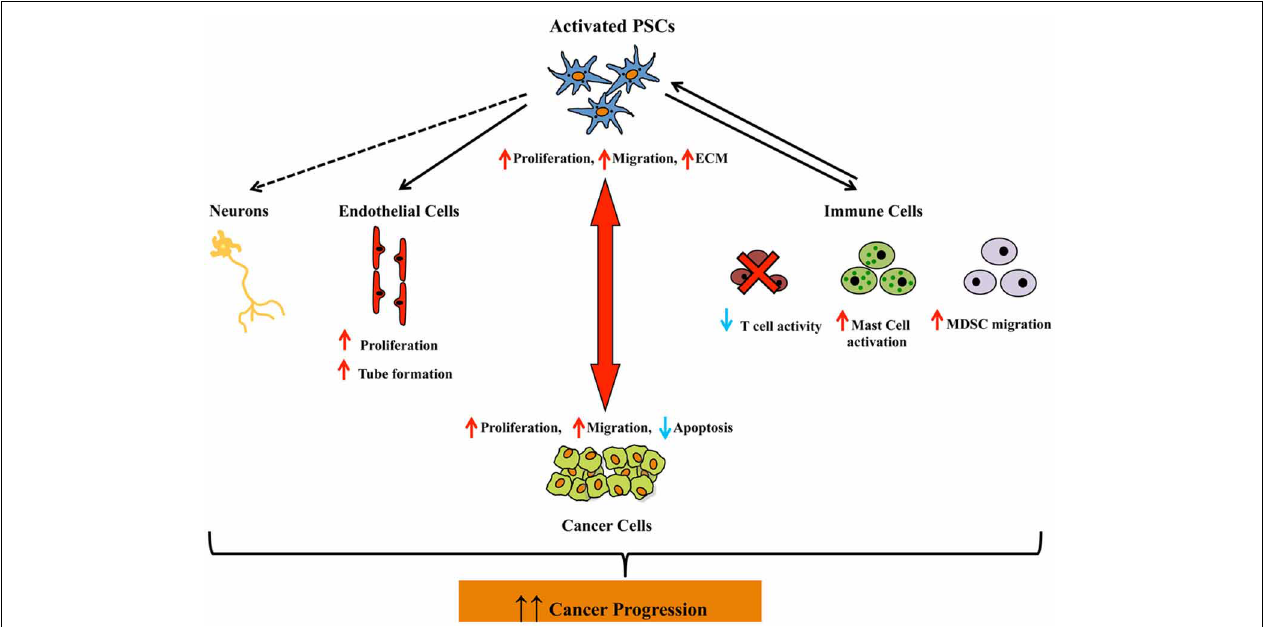
FIGURE 4 | Schematic diagram depicting the interactions between activated pancreatic stellate cells and pancreatic cancer cells, as well as pancreatic stellate cells and other stromal cells (endothelial cells, immune cells, and neuronal cells), all of which may promote pancreatic cancer progression. The dashed arrow between PSCs and neuronal cells